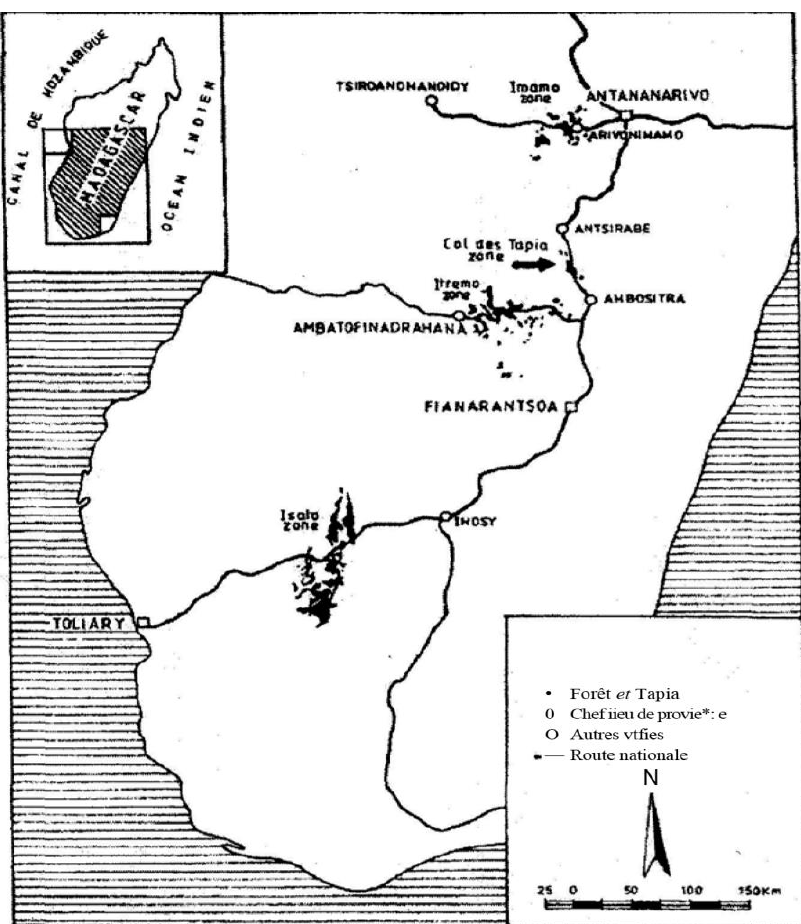
Figure 1. Tapia forests distribution in Madagascar.